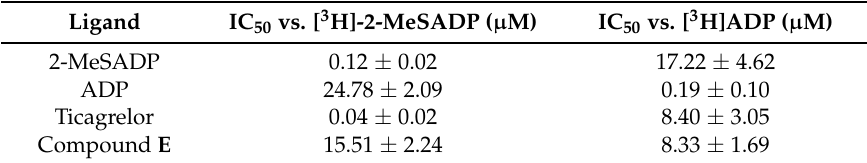
Table 3. Comparison of binding affinities against [ 3 H]-2-MesADP and [ 3 H]ADP ligands.